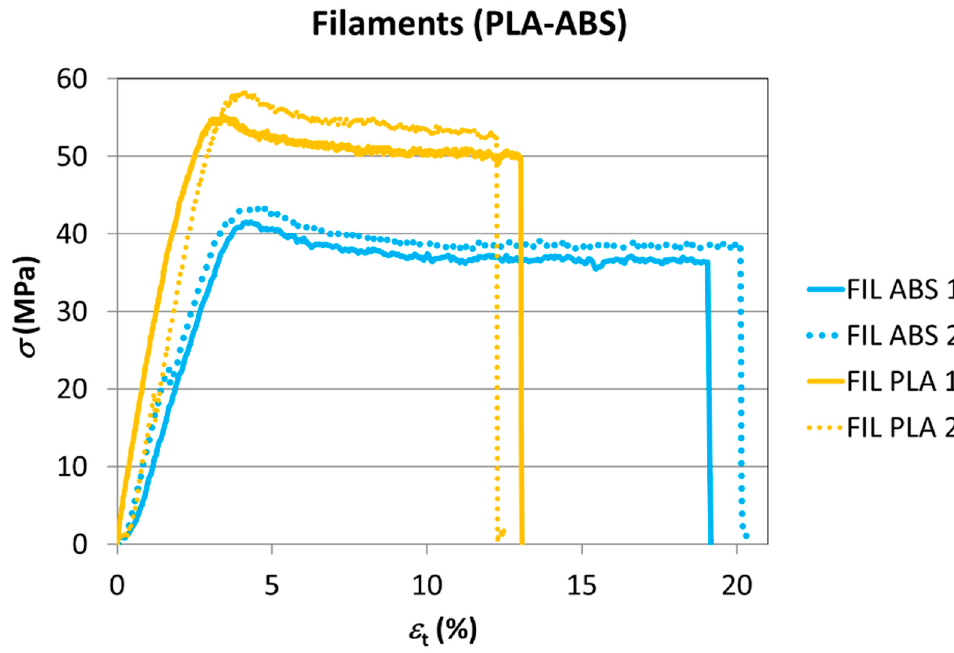
Figure 3. The tensile tests of the filaments.